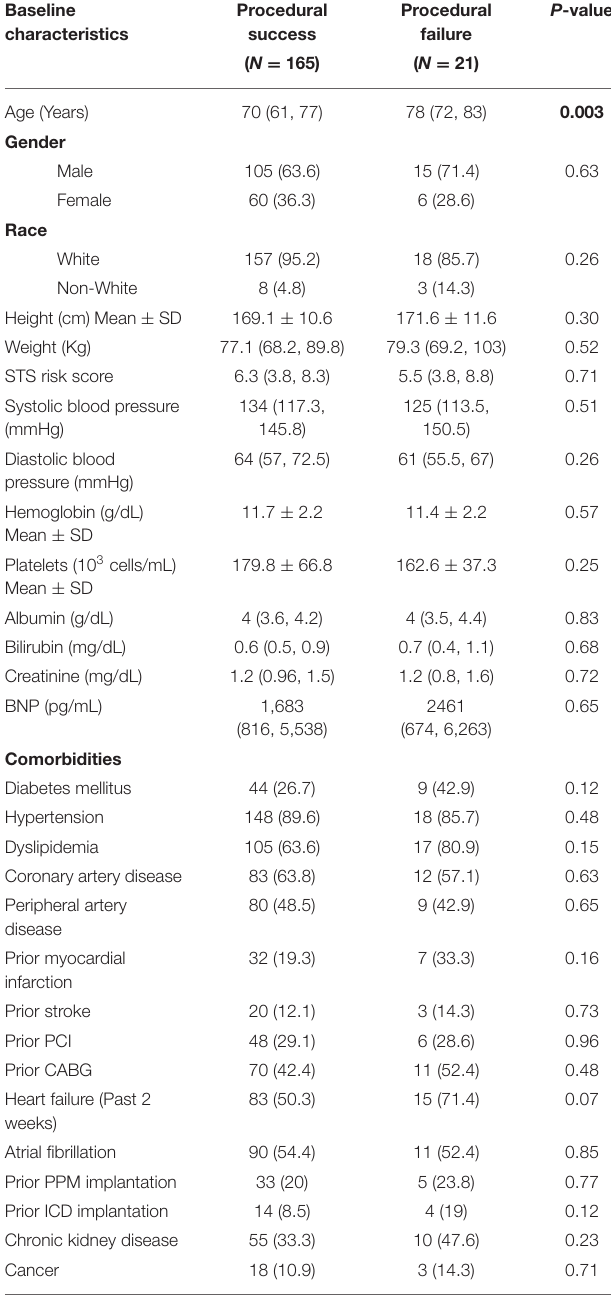
TABLE 1 | Baseline characteristics of patients in the procedural success and failure